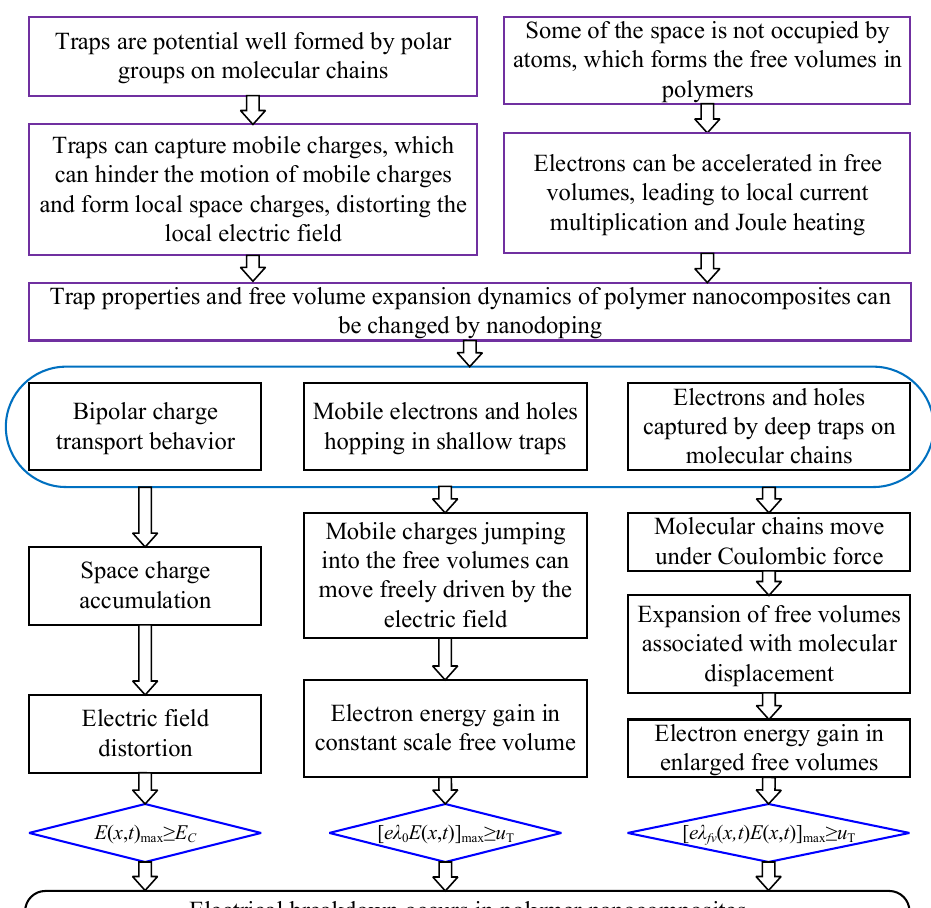
Figure 7. Schematic diagram of EBEF, EBEG, and EBMD